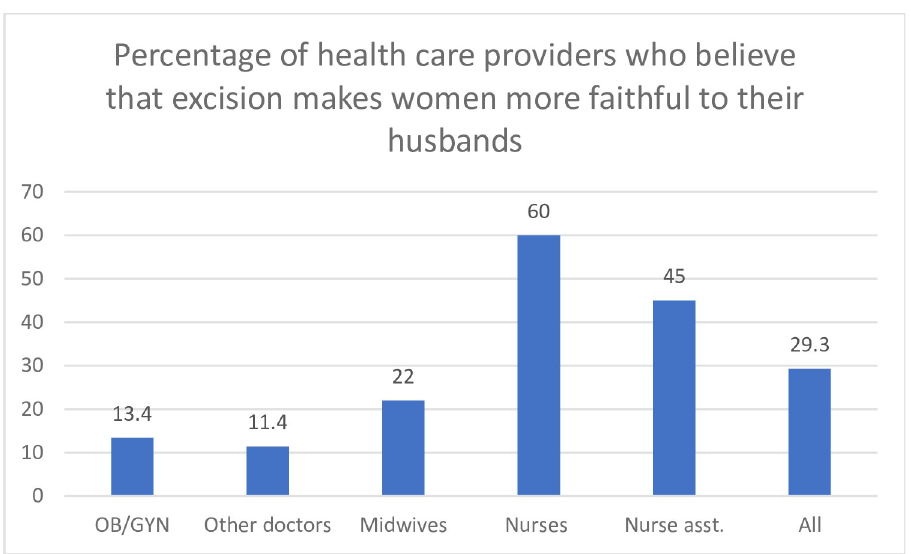
Fig 2. Percentage of health care providers who believe that excision makes women more faithful to their